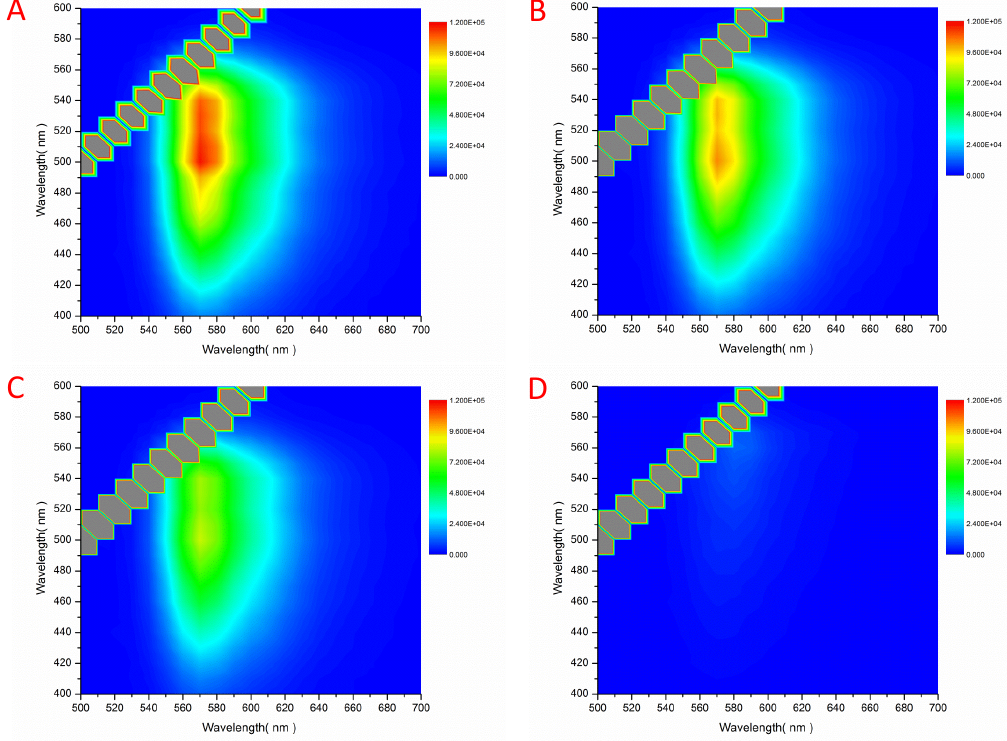
Figure 2. Fluorescence excitation/emission matrix scans of the water phase for Pb 2+ ion concentrations of: ( A ) 0 ( B ) 10 ppt ( C ) 500 ppt ( D ) 500 ppm. Note that the intensity scales are set the same.